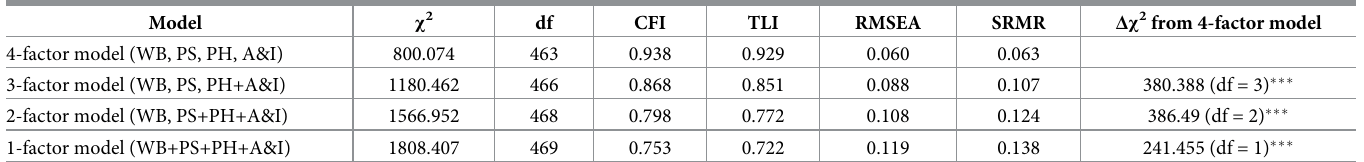
Table 3. Results for Chi-squared comparison test in Study 2.